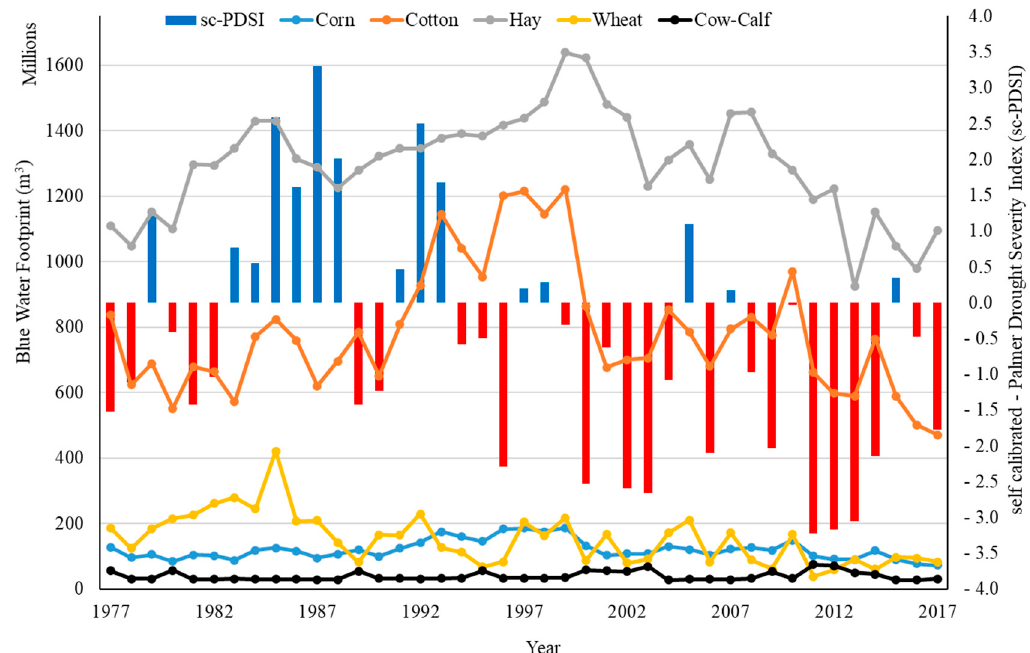
Figure 4. Relationship between annual blue water use of common New Mexico irrigated crops and cow-calf operations and self-calibrated Palmer Drought Severity Index (sc-PDSI) for the 1977–2017 period.